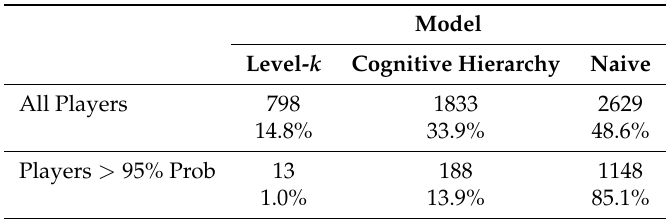
Table 11. Likeliest Model by